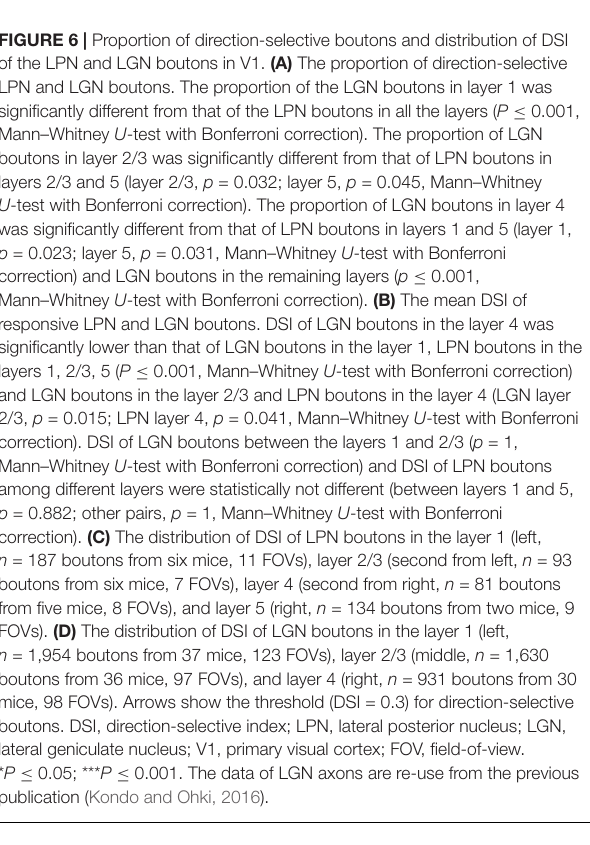
FIGURE 7 | Distribution of preferred directions of LPN and LGN boutons in V1. The distribution of preferred directions of LPN boutons (A) and LGN boutons (B) in each layer of V1. LPN boutons showed skewed bias from the horizontal to vertical direction, but this bias was less prominent than the orientation bias of LPN boutons. In contrast, LGN boutons showed cardinal bias, which was also less prominent than the orientation bias of LGN boutons. LPN, lateral posterior nucleus; LGN, lateral geniculate nucleus; V1, primary visual cortex. The data of LGN axons are re-use from the previous publication (Kondo and Ohki,